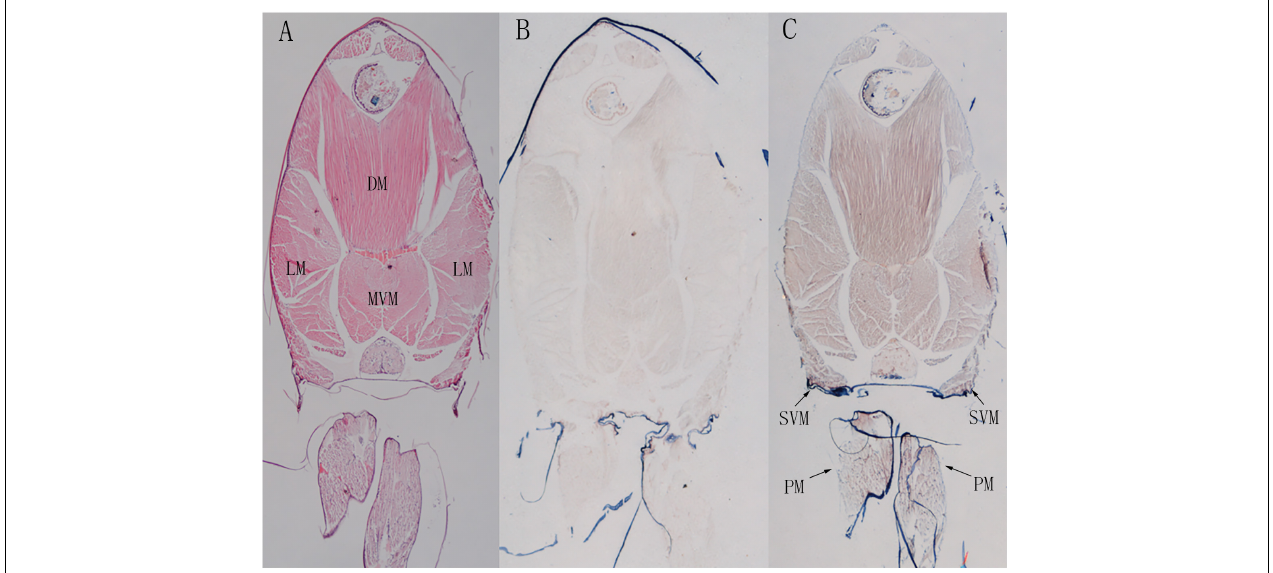
FIGURE 9 | The localization of LvMYH5 in the abdominal muscle and pleopod muscle of L. vannamei . (A) Hematoxylin-eosin (H&E) staining and (B) a sense probe were used as the control for (C) the antisense probe hybridization. LM, the lateral muscle; DM, the dorsal muscle; MVM, the main ventral muscle; PM, the pleopod muscle; SVM, the superficial ventral muscle. The picture of H&E staining was from our previous study (Zhang et al.,